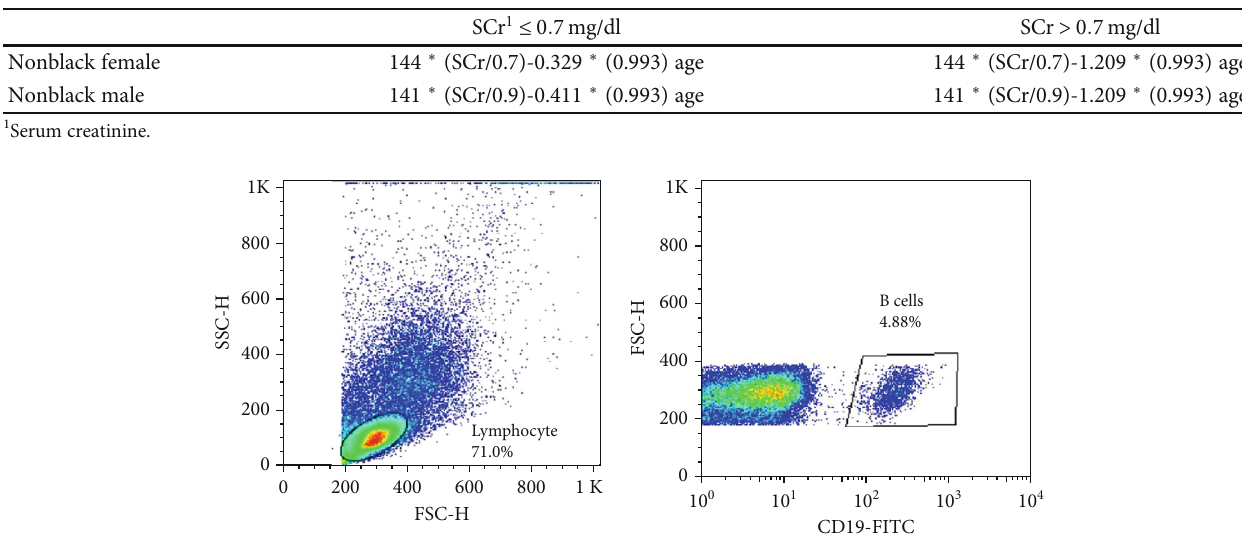
Table 3: Estimated GFR formula.